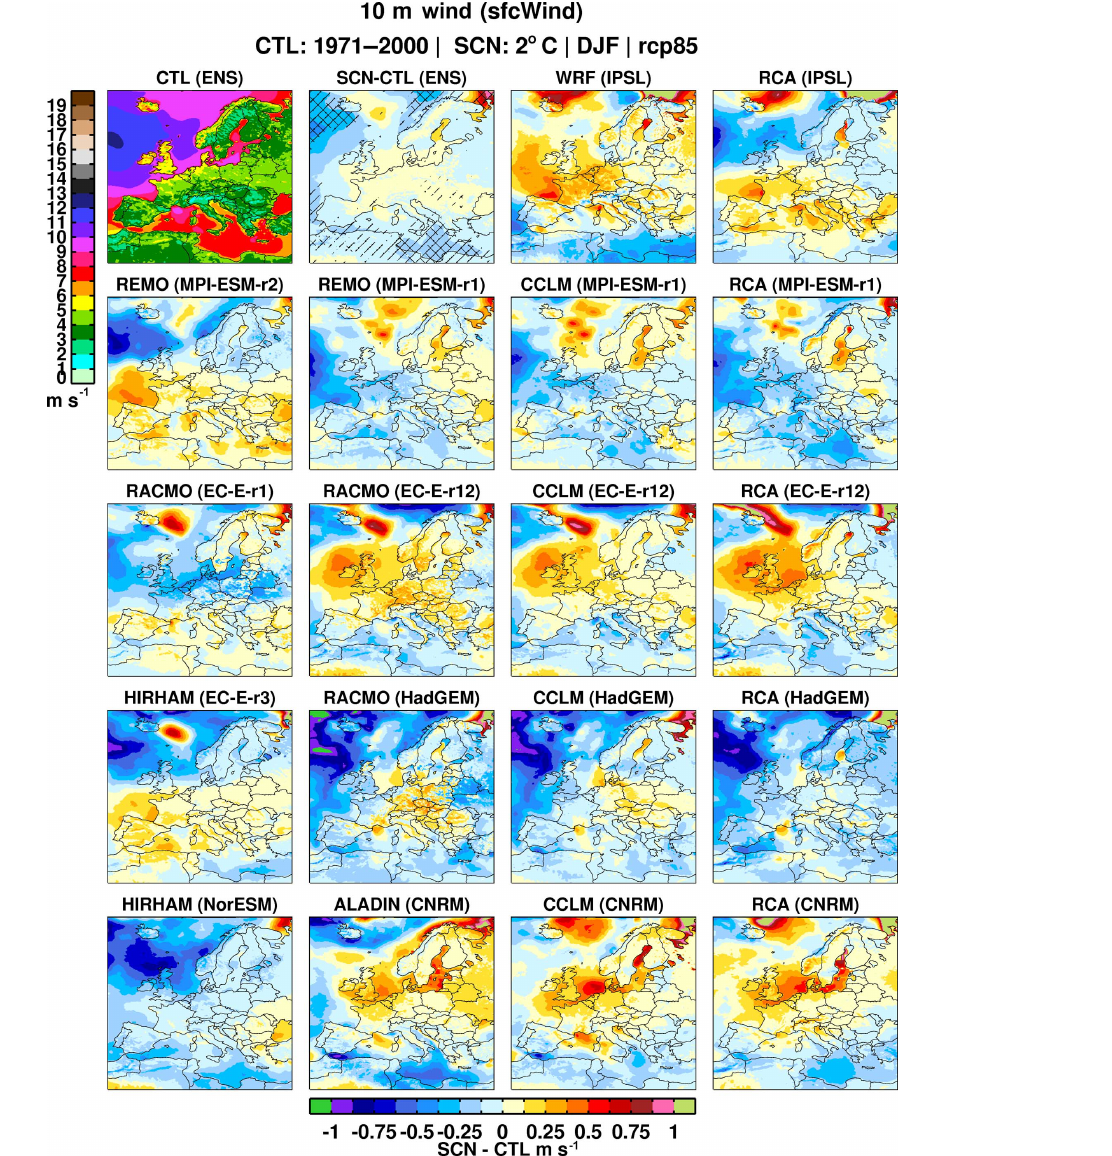
Figure 7. Winter (DJF) 10m wind speed in the reference period (ensemble mean in the uppermost left panel) and its change in 18 RCM simulations in Table 1 (two uppermost right panels and all other rows) for the + 2 ◦ C of warming level (SWL2). Hatching in the ensemble mean signal (second upper panel from the left) represents areas where at least 14 of the 18 ensemble members agree on the sign of change. Cross-hatching indicates that there is agreement on the sign of change and that the signal-to-noise ratio is larger than